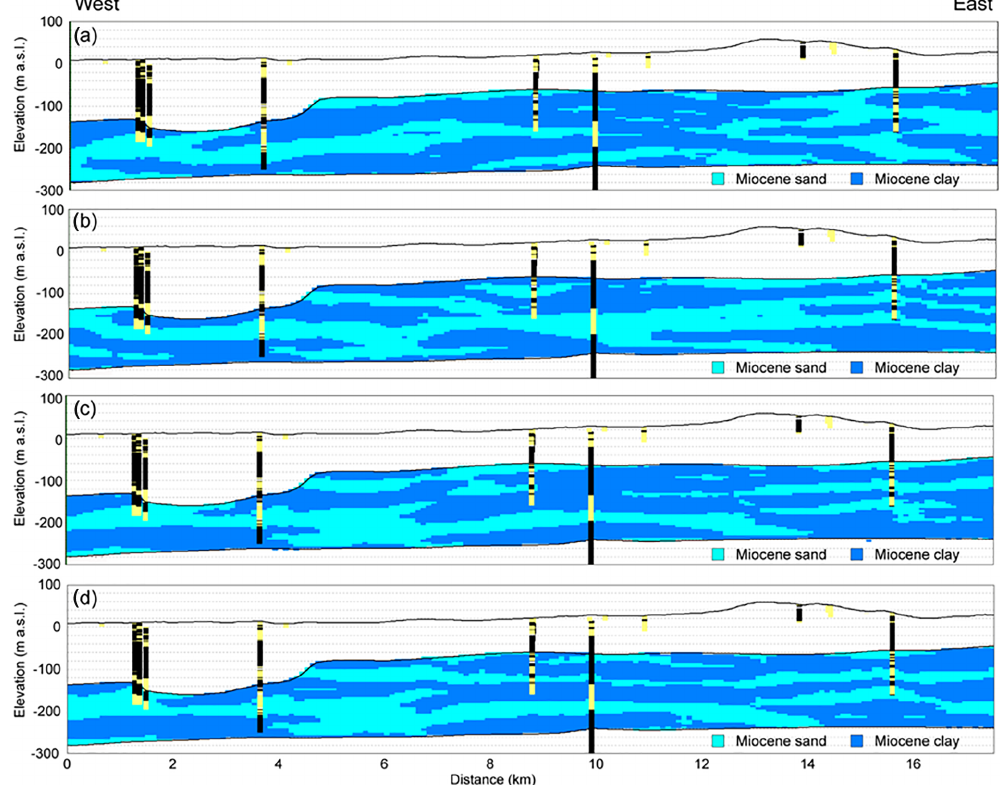
Figure 16. Profile through the realizations generated by using different conditional strategies (see Table 1). The borehole information used for conditioning is illustrated in Fig. 8: (a) unconditioned; (b) borehole as hard data (Fig. 8a); (c) borehole as soft data (Fig. 8b); (d) sand probability grid derived by boreholes as soft data (Fig. 8c). Sand / clay information from the original boreholes are shown within a buffer of 100m (yellow: sand; black: clay; white: “other”). For location of the profile, see Fig. 15. Vertical exaggeration = 8 × .